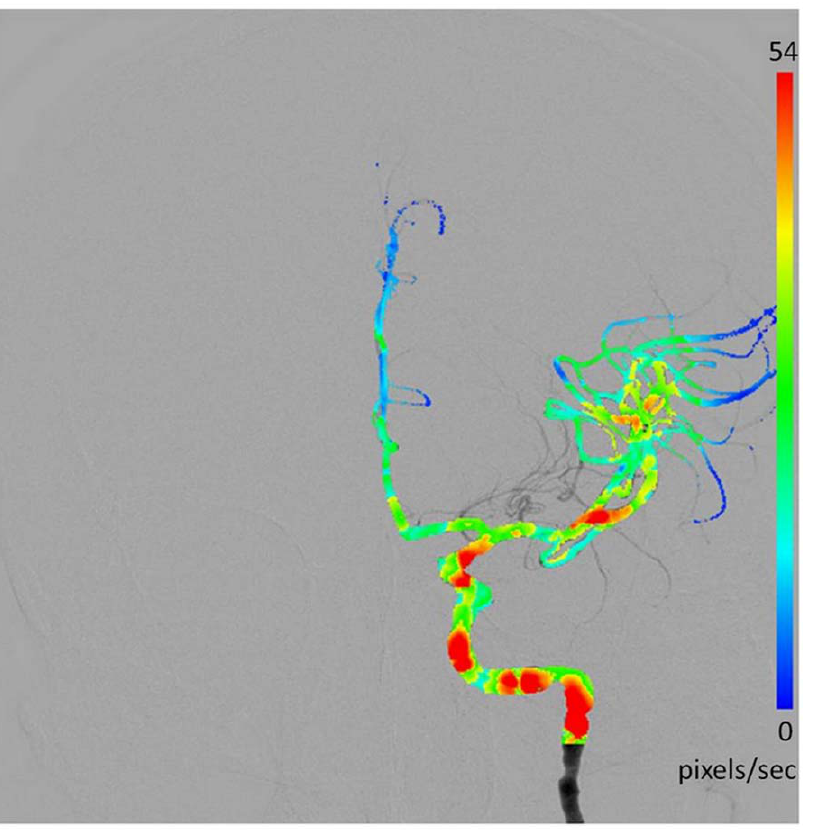
Figure 3. A representative OFM calculated blood flow velocity distribution is presented on the DSA images with color-coding in an aneurysm patient. The fast flow is in red and the slow flow is in blue. The maximum velocity was 54 pixels/second (red). (a) AP view; (b) lateral view.